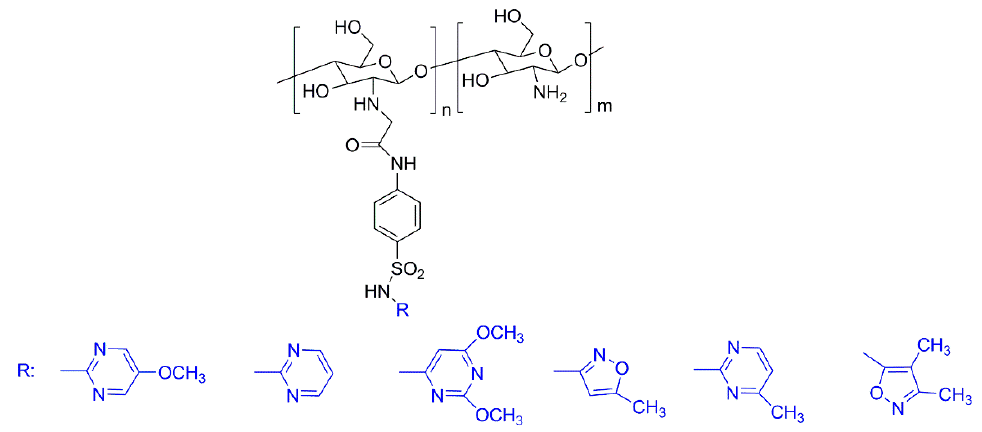
Figure 10. Structures of the sulfonamide-chitosan derivatives prepared by Dragostin et al. (adapted from